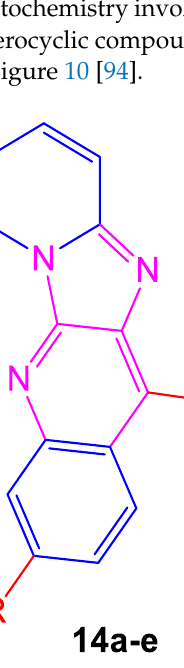
Figure 10. Structures of compounds ( 14a – 14e ) showing photochemical activity.